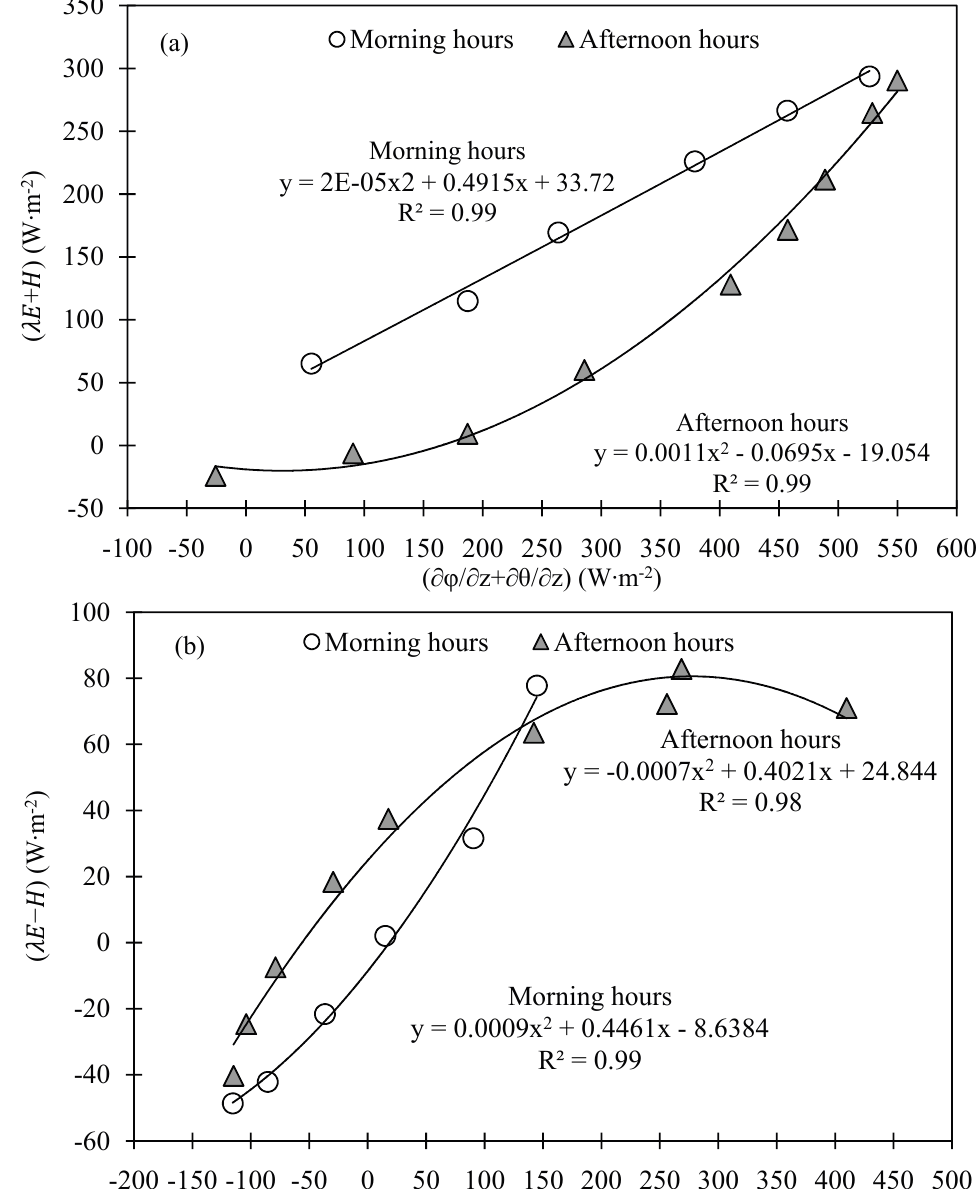
Figure 7. ( a ) Latent heat plus sensible heat ( (cid:2019)(cid:1831) + (cid:1834) ) vs. moisture gradient and sensible heat gradient ( ∂φ / ∂ z + ∂θ / ∂ z); ( b ) Expression of the difference between latent and sensible heat ( λ E − H ) as a function of the difference between moisture gradient and sensible heat gradient ( ∂φ / ∂ z − ∂θ / ∂